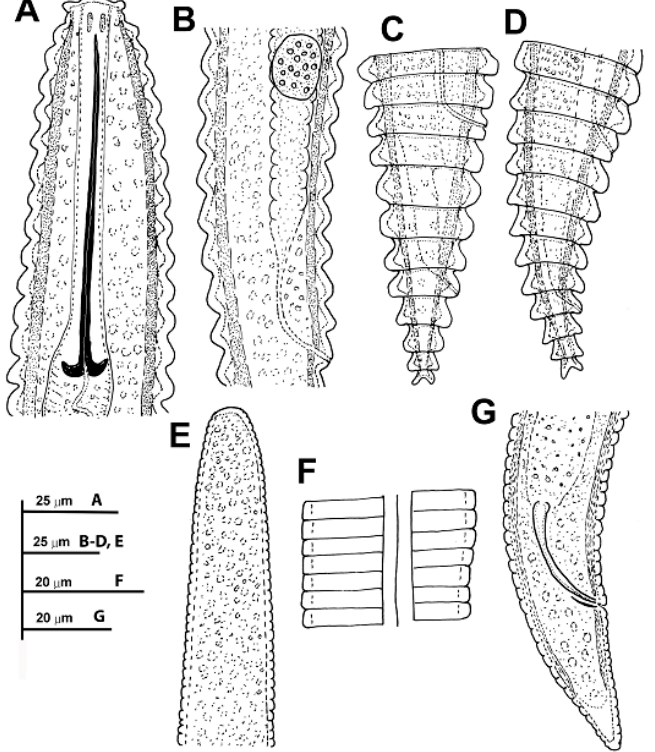
Figure 3. Line drawings of Criconema paraannuliferum sp. nov. ( A ), female anterior region; ( B ), detail of spermatheca; ( C , D ), female posterior region; ( E ), male anterior region showing absence of stylet; ( F ), male lateral field at mid-body; ( G ), male posterior region.